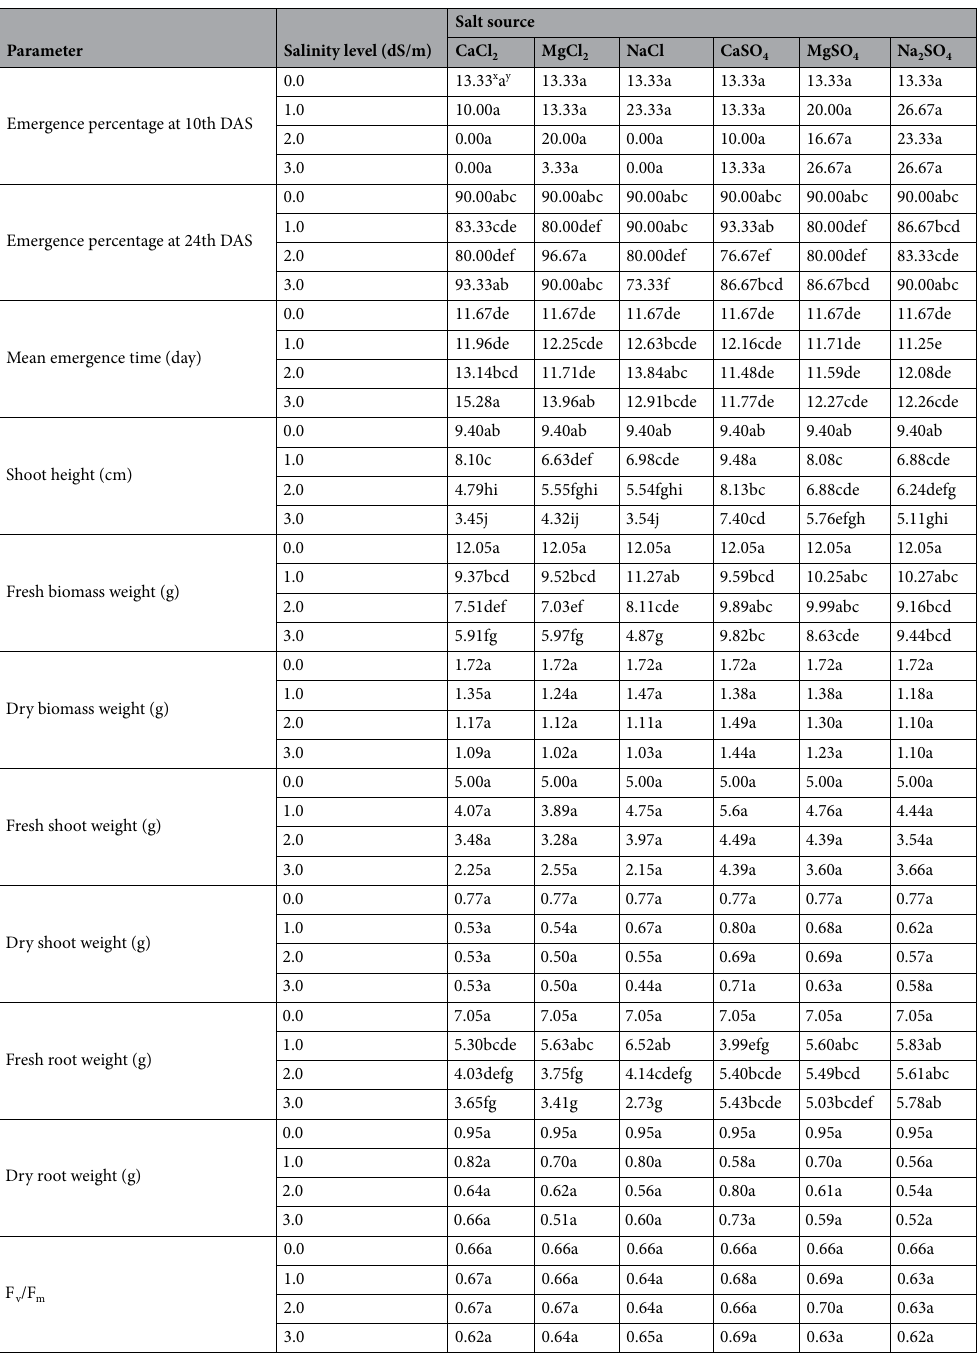
Table 5. The interaction effects of S × L on III-28 faba bean genotype. x Each value is the mean of three replications. y Within salt source and salinity level of each parameter, means followed by the same letter are not significantly different at the 5% level according to Duncan’s multiple range